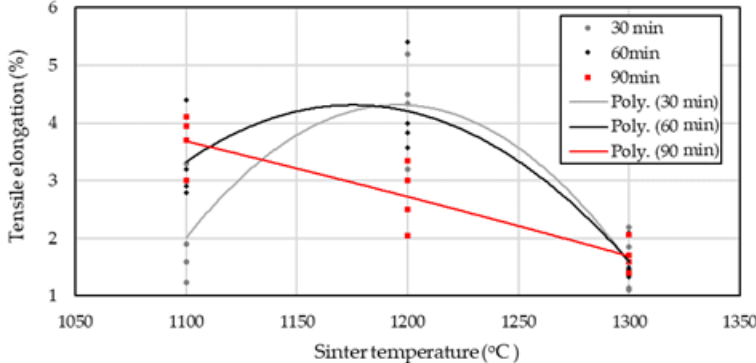
Figure 11. Tensile elongation of sintered titanium